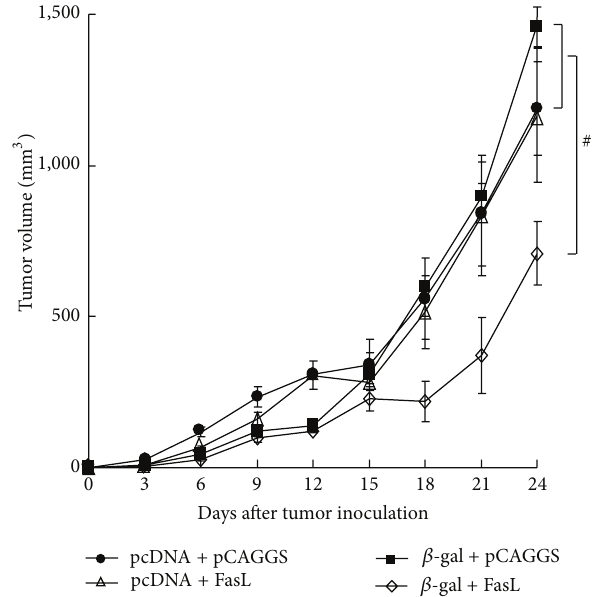
Figure 2: Antitumor effects produced by DNA immunization. BALB/c mice ( 𝑛 = 6 or 7) were treated with cardiotoxin and 5 days later with DNA (50 𝜇 g for each), pcDNA3 + pCAGGS, pcDNA3 + pCAGGS/FasL (FasL), pcDNA3/ 𝛽 -gal ( 𝛽 -gal) + pCAGGS, or pcDNA3/ 𝛽 -gal + pCAGGS/FasL ( 𝛽 -gal + FasL). The mice were then inoculated with Colon 26/ 𝛽 -gal cells (1 × 10 6 ) 21 days after DNA injections. The tumor growth of mice injected with cDNA3/ 𝛽 -gal + pCAGGS/FasL was significantly retarded 21 days after the tumor inoculation compared with that of mice inoculated with pcDNA3 + pCAGGS,pcDNA3+pCAGGS/FasL,orpcDNA3/ 𝛽 -gal+pCAGGS. # 𝑃 < 0.05